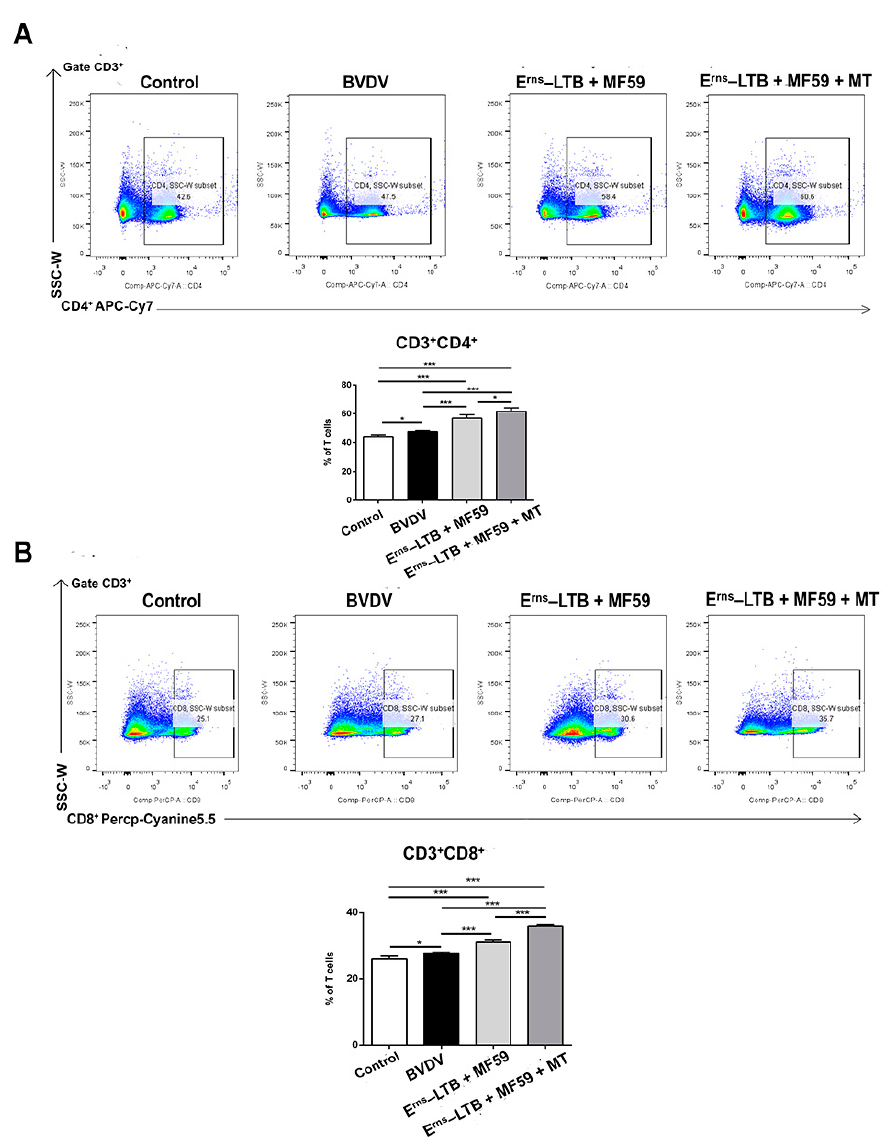
Figure 4. The proportion of peripheral blood lymphocytes CD3 + CD4 + T cells and CD3 + CD8 + T cells. One week after the BVDV challenge, blood was collected aseptically for lymphocyte isolation from mice in each group. ( A ) Flow cytometric analysis of the percentage of CD3 + CD4 + cells among CD3 + T cells. Top: representative flow cytometry dot plot shows the gating strategy for CD4 in peripheral CD3 + T cells. Down: The data are the mean percentage of CD3 + CD4 + cells among CD3 + T cells. ( B ) Flow cytometric analysis of the percentage of CD3 + CD8 + cells among CD3 + T cells. Top: representa- tive flow cytometry dot plot shows the gating strategy for CD8 in peripheral CD3 + T cells. Down: The data are the mean percentage of CD3 + CD8 + cells among CD3 + T cells ± SEM of three individual mice from each group detected in triplicate. * p < 0.05; *** p < 0.001. 3.6. Colon Permeability The levels of tight junction proteins (claudin-1 and occludin) were significantly in- creased in the BVDV group at p < 0.001 (Figure 5) compared to the control group. How- ever, in mice immunized with the vaccine containing MT, the levels of claudin-1 and oc- cludin were significantly decreased in the colon compared to the BVDV group at p < 0.001 (Figure 5).